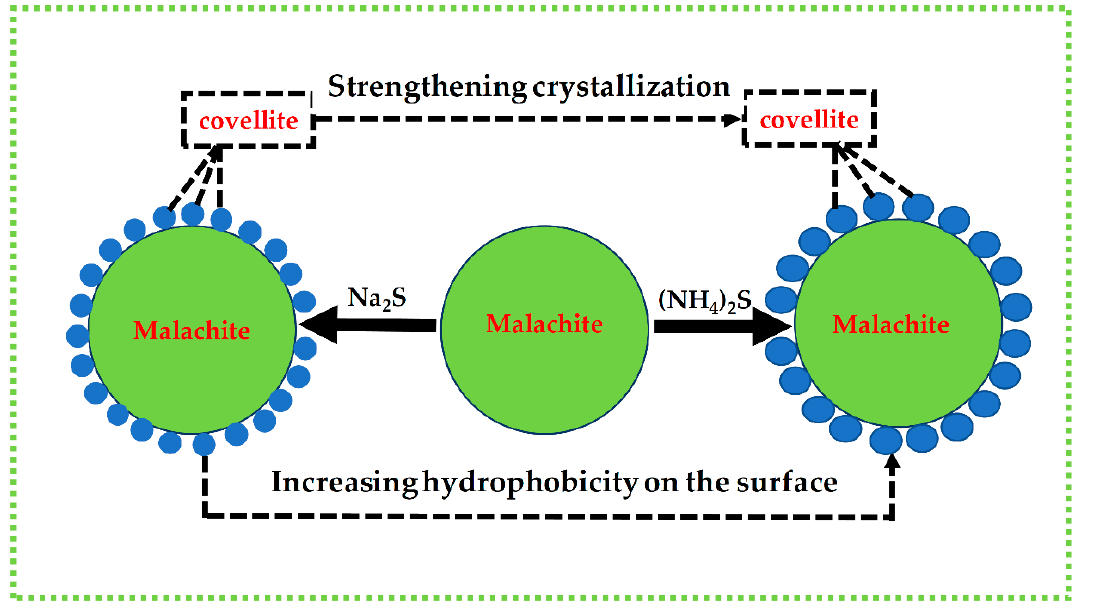
Figure 12. Graphical model of increasing hydrophobicity on the malachite surface by sodium sulfide and ammonium sulfide.